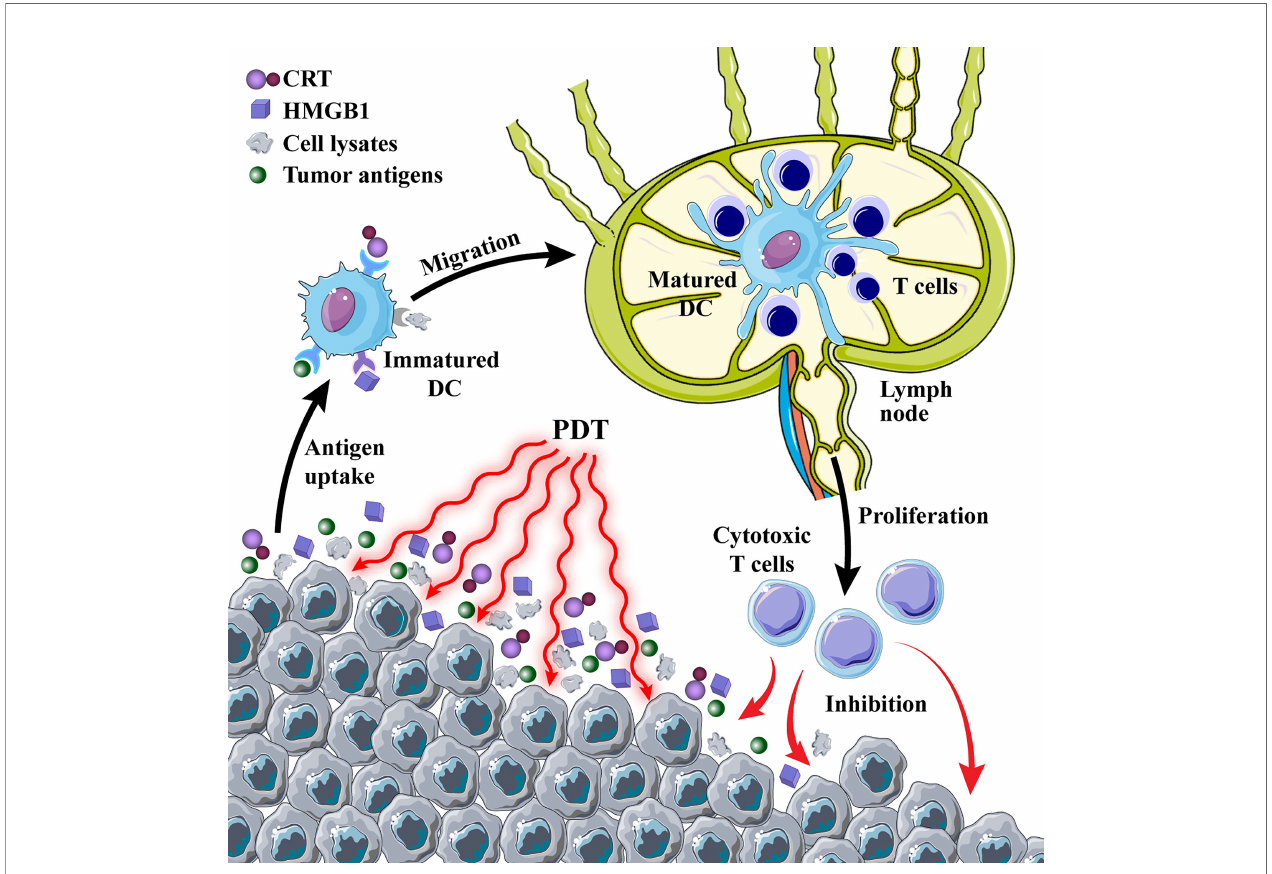
FIGURE 3 | Photodynamic therapy (PDT)-induced immune response. PDT induces immunogenic cell death and promotes the release of calreticulin (CRT) and high mobility group box 1 protein (HMGB1) from tumor cells; tumor cell lysates and antigens are used as cancer vaccines to cause a series of immune